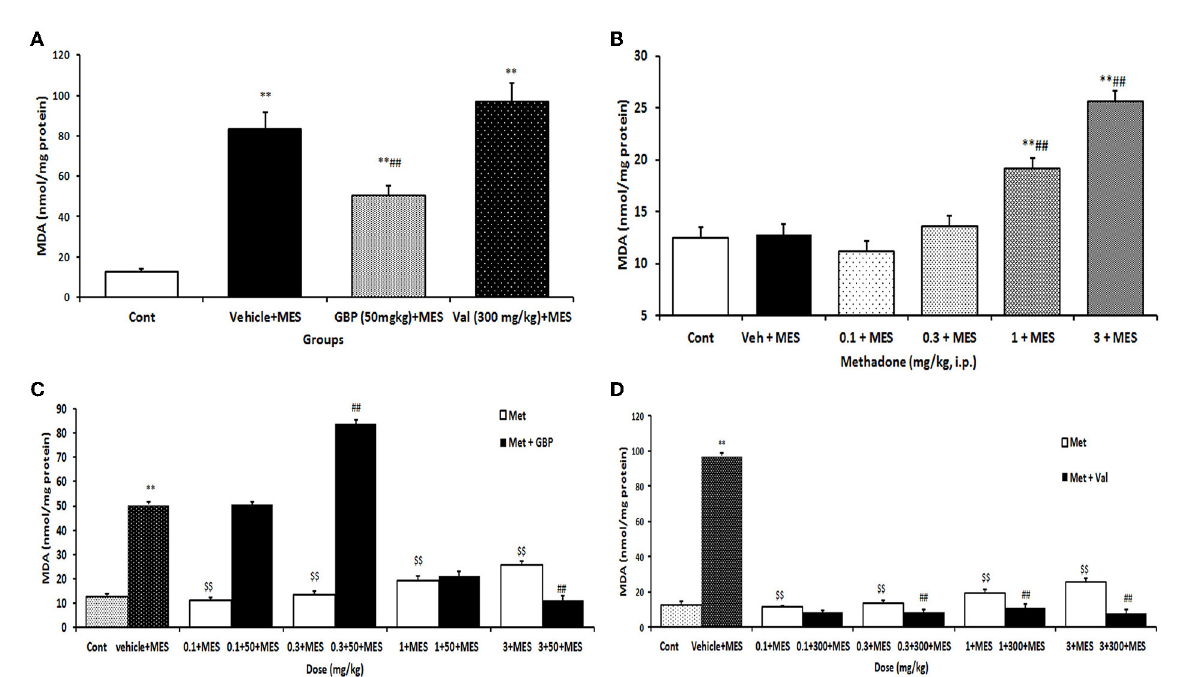
FIGURE1 Changes of MDA (nmol/mg protein) in the brain of mice in different treatment groups: (A) changes of brain MDA level in the saline-treated control, 50 mg/kg i.p. gabapentin (GBP) and 300 mg/kg i.p. valproate (Val)-treated groups after MES-induced seizure; (B) changes of brain MDA level of mice after treatment with (0.1, 0.3, 1, and 3 mg/kg i.p.) Met and MES-induced seizure; (C) changes of brain MDA level treated with GBP (50 mg/kg i.p.) per se and different doses of Met plus GBP before MES; (D) changes of brain MDA level treated with valproate (Val) (300 mg/kg i.p.) per se and different doses of Met plus Val before MES. Data are expressed as mean ± SEM. N = 10. ** p < 0.01compared with the normal group, $$ p < 0.01 treatments vs. vehicle + MES, and ## p < 0.001 compared with the saline + MES group using one-way ANOVA followed